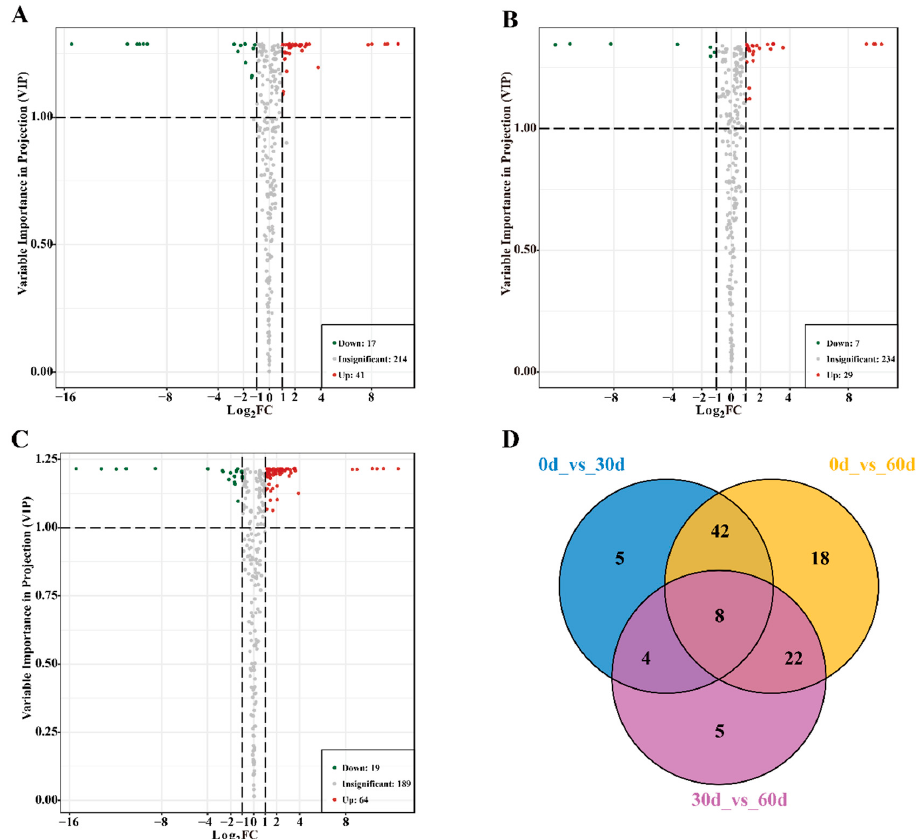
Figure 3. Screening of differential metabolites in ‘Fengtang’ plum fruits during storage: ( A ) Volcanic maps of differential metabolites at 0 d vs. 30 d, ( B ) Volcanic maps of differential metabolites at 30 d vs. 60 d, ( C ) Volcanic maps of differential metabolites at 0 d vs. 60 d. ( D ) Venn diagram of differential metabolites between groups.